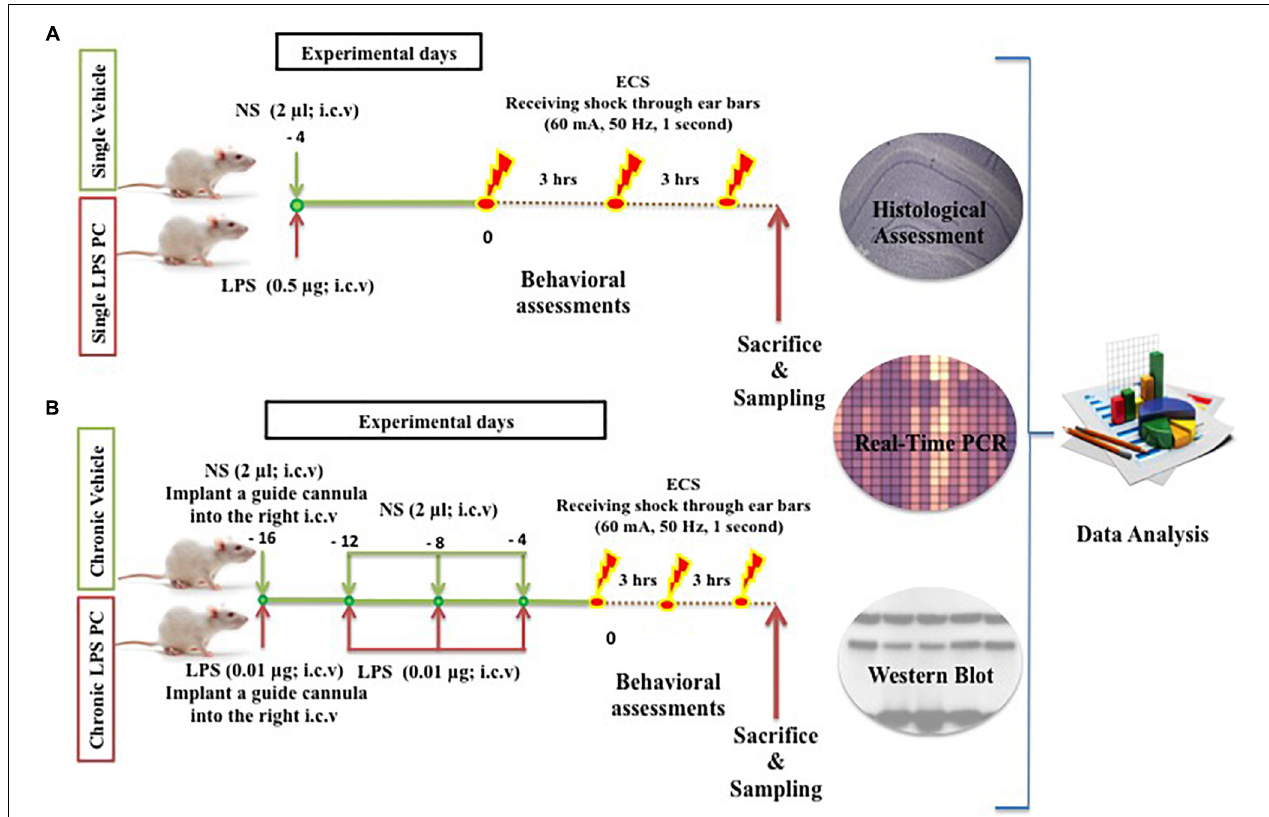
FIGURE 1 | Schematic diagram of experimental design and procedures in the (A) single and (B) chronic LPS preconditioning and vehicle groups in this